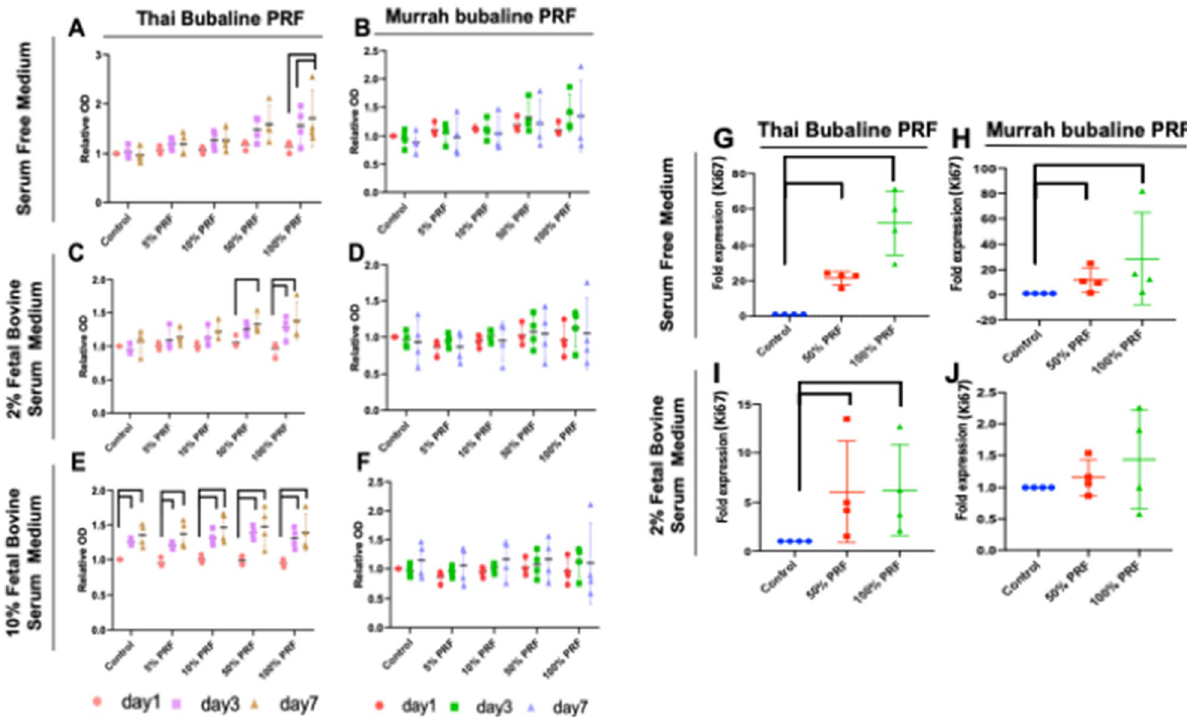
Figure 3. Effects of Thai and Murrah bubaline blood derived platelet rich fibrin (PRF) on cPDLs proliferation. Thai and Murrah bubaline blood derived PRF were prepared into 5%, 10%, 50%, and 100% concentration. Cells were maintained in serum free ( A and B ), 2% FBS ( C and D ), or 10% FBS ( E and F ) culture medium. Cell viability was examined using MTT assay at day 1, 3, and 7. cPDLs proliferation was significantly increased after treated with Thai bubaline blood derived PRF. Bars indicated the statistically significant difference. (Two-way ANOVA test with Turkey’s multiple comparisons test, p < 0.05). Correspondingly, Thai and Murrah bubaline blood derived PRF induced KI67 mRNA expression in cPDLs. Thai and Murrah bubaline blood derived PRF were prepared into 50% and 100% concentration. Cells were treated with PRF for 24 h in serum free ( G and H ) or 2% FBS ( I and J ) culture medium. KI67 mRNA levels were determined using real-time polymerase chain reaction. Bars indicated the statistically significant difference. (Mann Whitney U test, p <